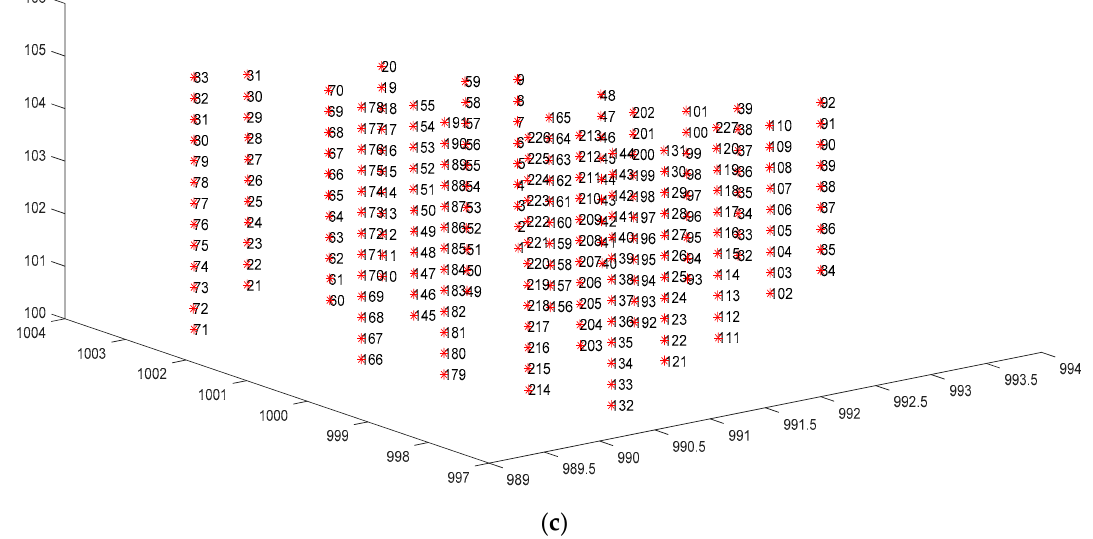
Figure 2. Data source of the simulation scene. ( a ) Left image and the feature points. ( b ) Right image and the feature points. The symbols + with the same number in (a) and (b) are a pair of matching points. ( c) The true coordinates of 3D points (symbols *) corresponding to matching points.